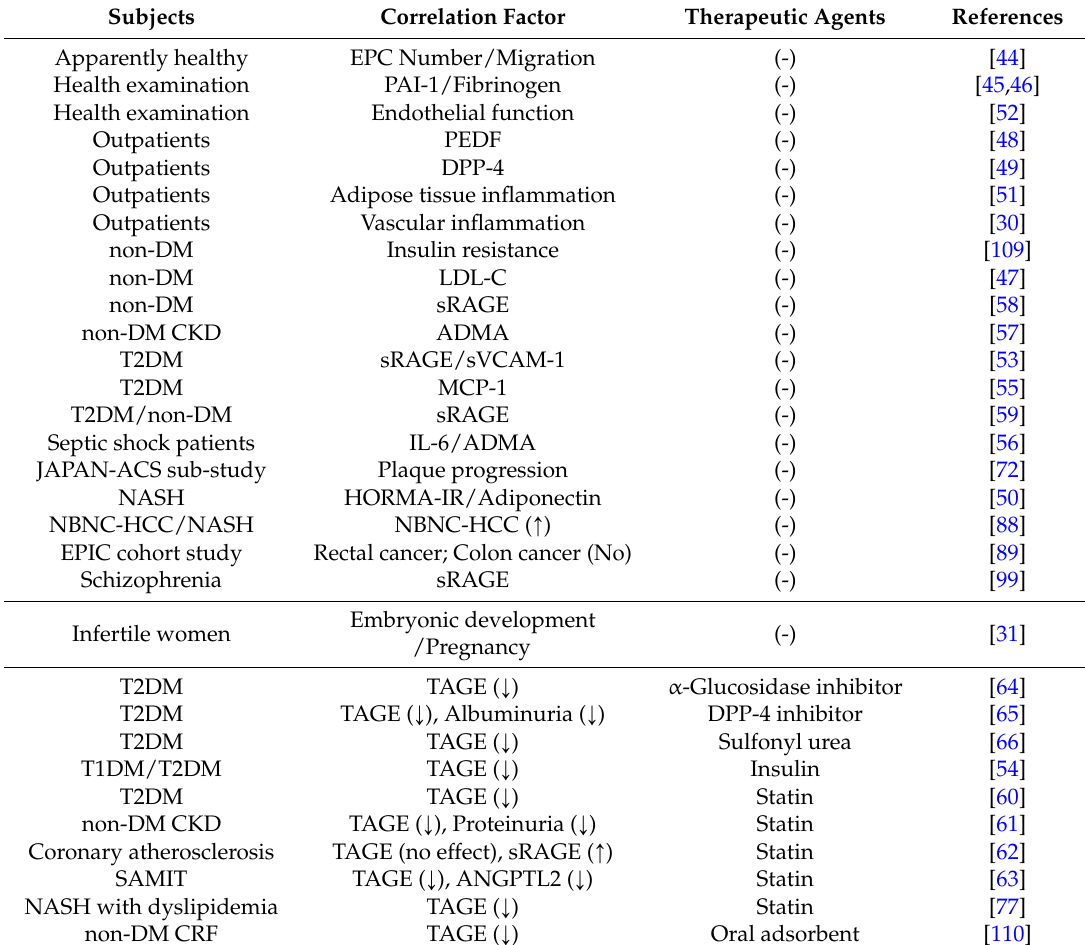
Table 1. Clinical relevance of serum TAGE